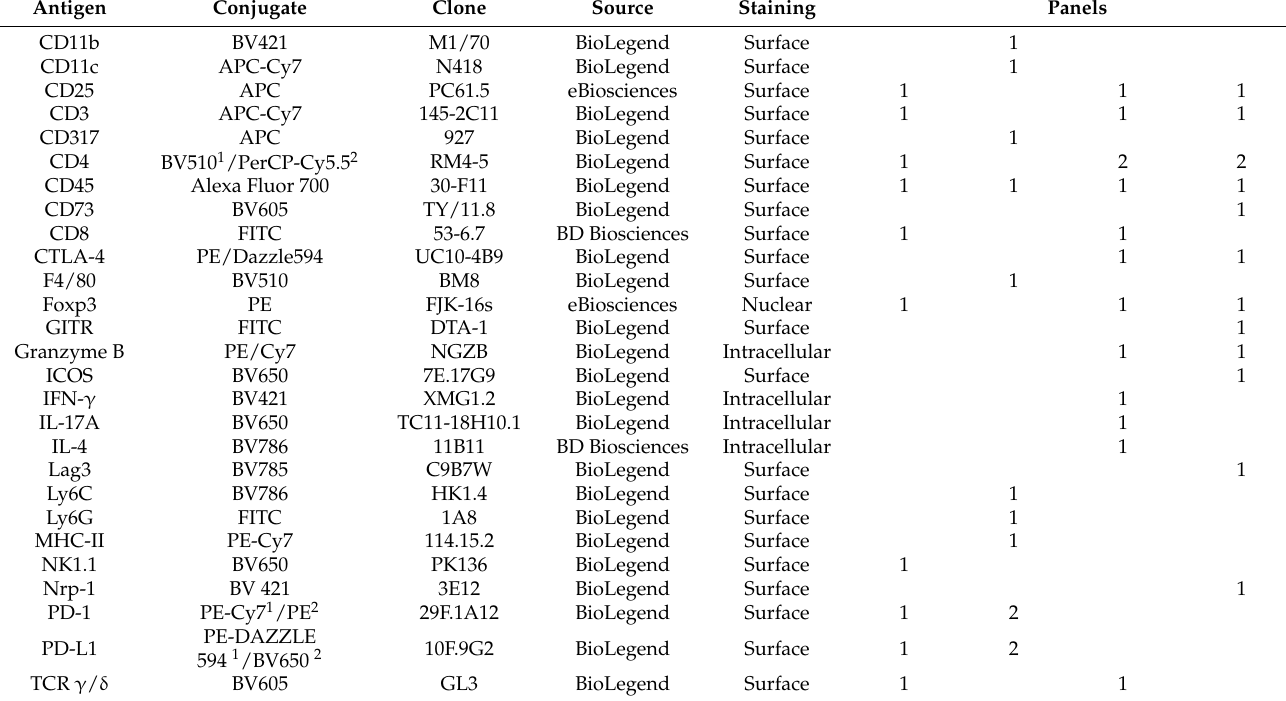
Table 1. Antibodies for flow